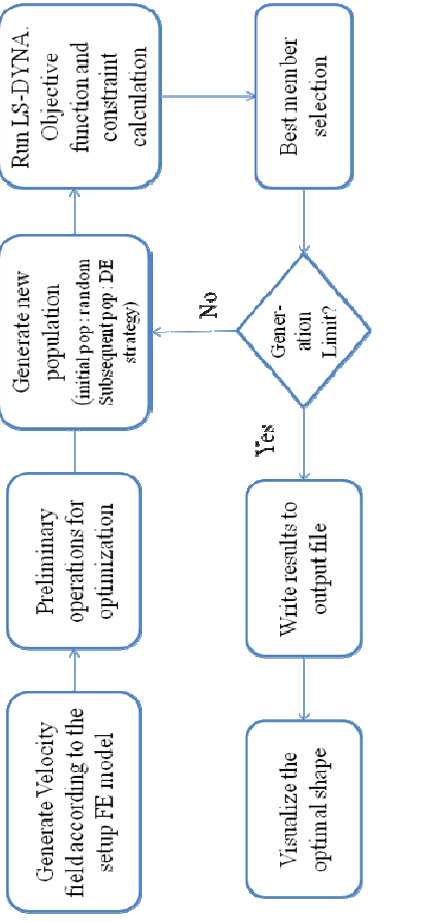
Fig. 3. Flow Diagram of the computer code for shape optimi- zation using LS-DYNA